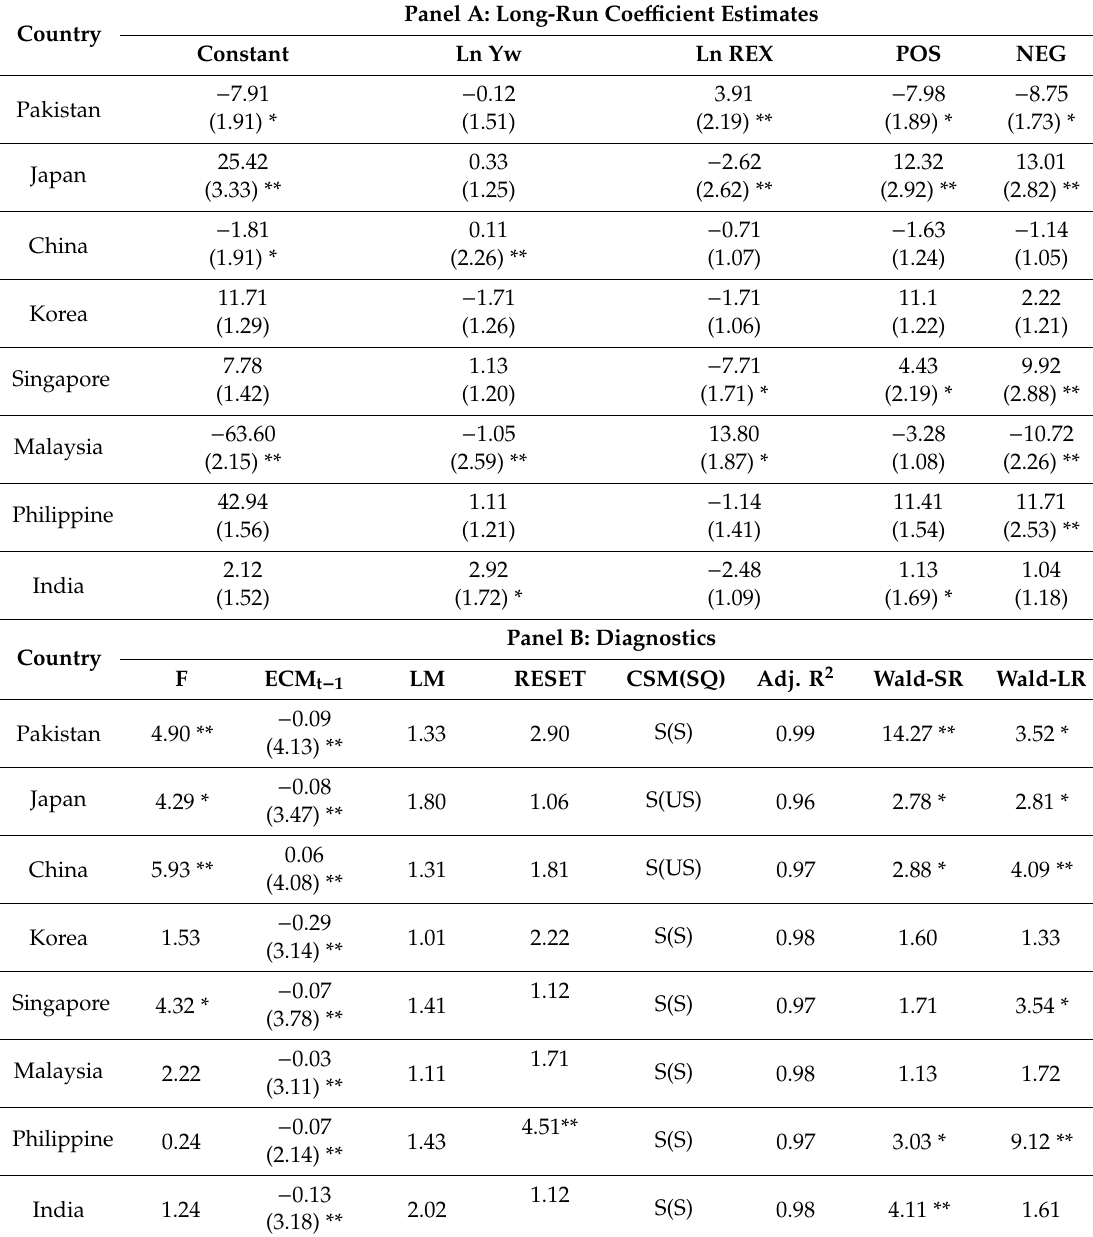
Table 6. Long-Run Coe ffi cient Estimates and Diagnostics of the Non-Linear Export Demand Model (6). Country